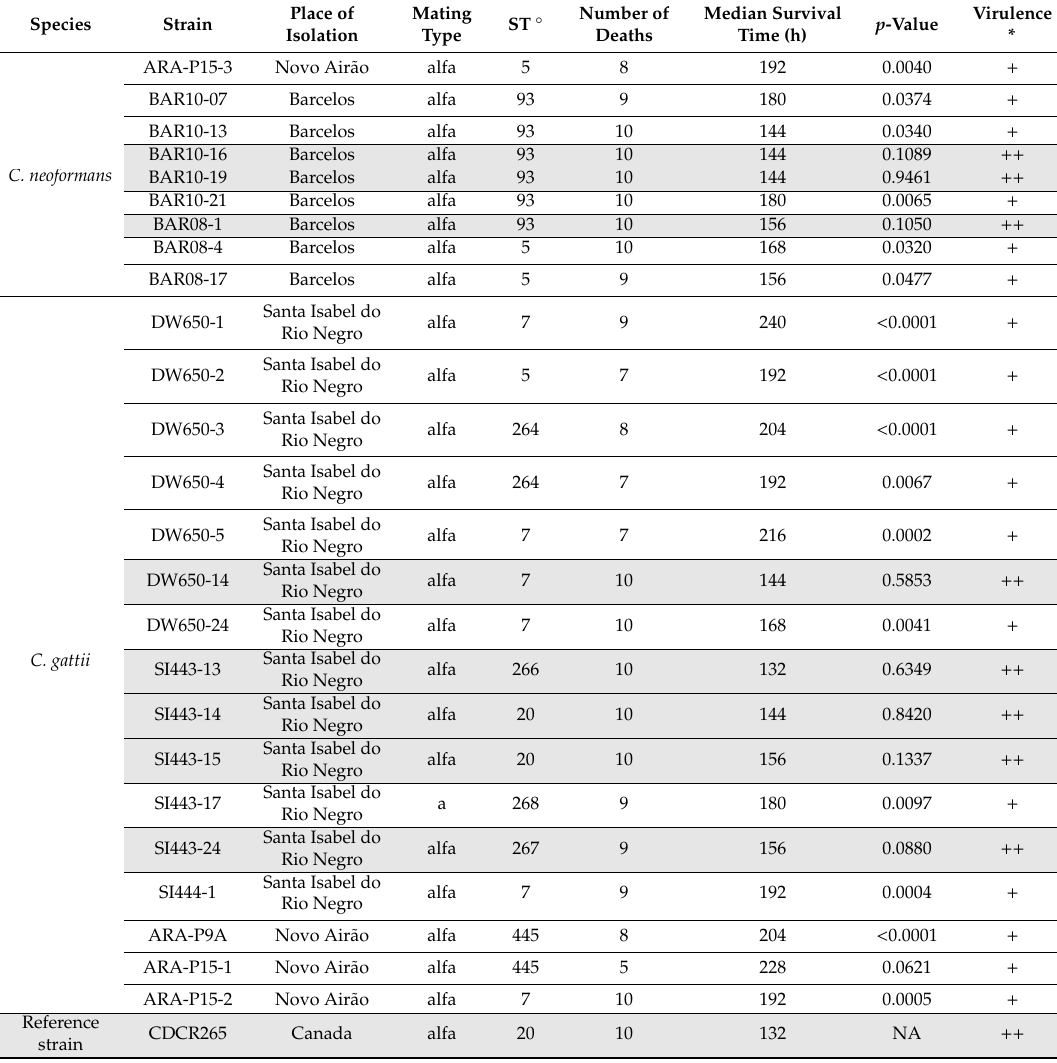
Table 2. Median survival times (MST) of Galleria mellonella larvae after being inoculated with the di ff erent strains of cryptococcal isolates recovered in this study. Median survival time from Cryptococcus neoformans isolates (n = 9) and C. gattii isolates (n = 16) were compared with the highly virulent strain CDCR265 (VGIIa) to determine the degree of virulence. Strains that were of comparable virulence with CDRC265 ( p > 0.05) are highlighted in